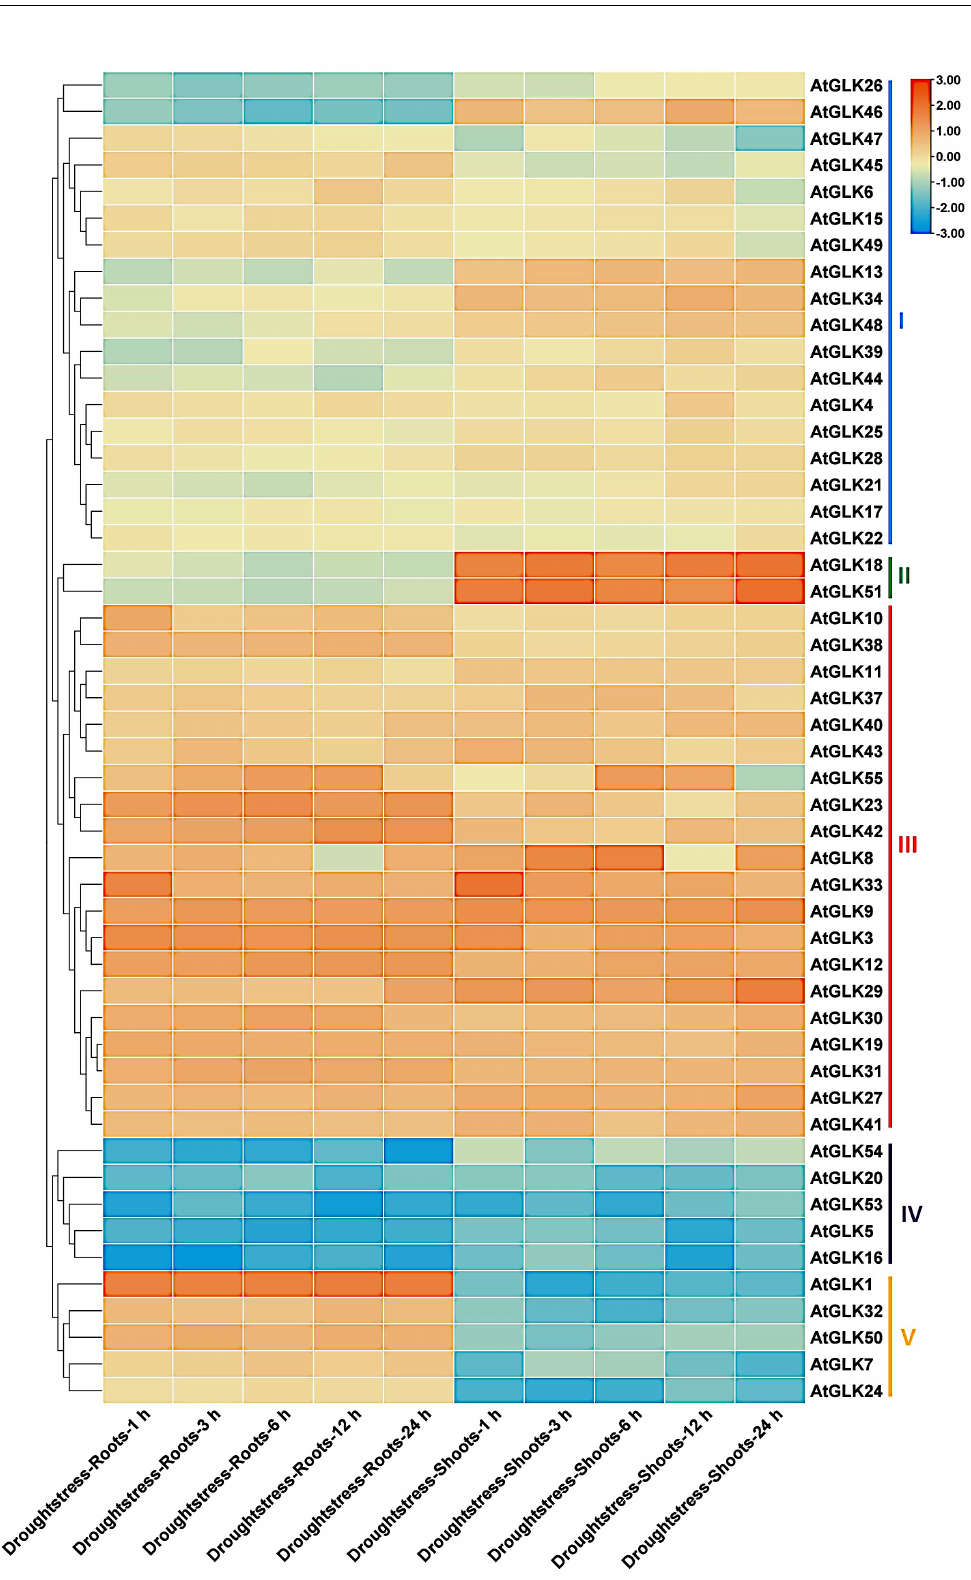
Figure 5. The expression of AtGLK genes in roots and shoots under drought responses. Heatmap generated from microarray experiments. Treatments and replicate numbers were determined by Kilian et al. [36]. Two biological replicates’ intensity values were pooled and normalized following the control treatment (treatment/control) in the heatmap. Control roots and shoots represent non-stressed tissue. The brown and the blue intensities show high and low expression levels,